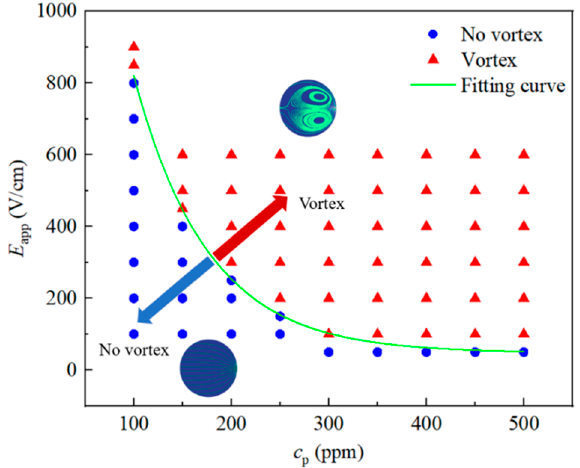
Figure 15. Flow map in c p - E app space for EOF of PAA solutions flowing through a 10:1:10 constriction/expansion microchannel. Up-right of the fitting curve are the conditions that trigger the vortex in the EOF.